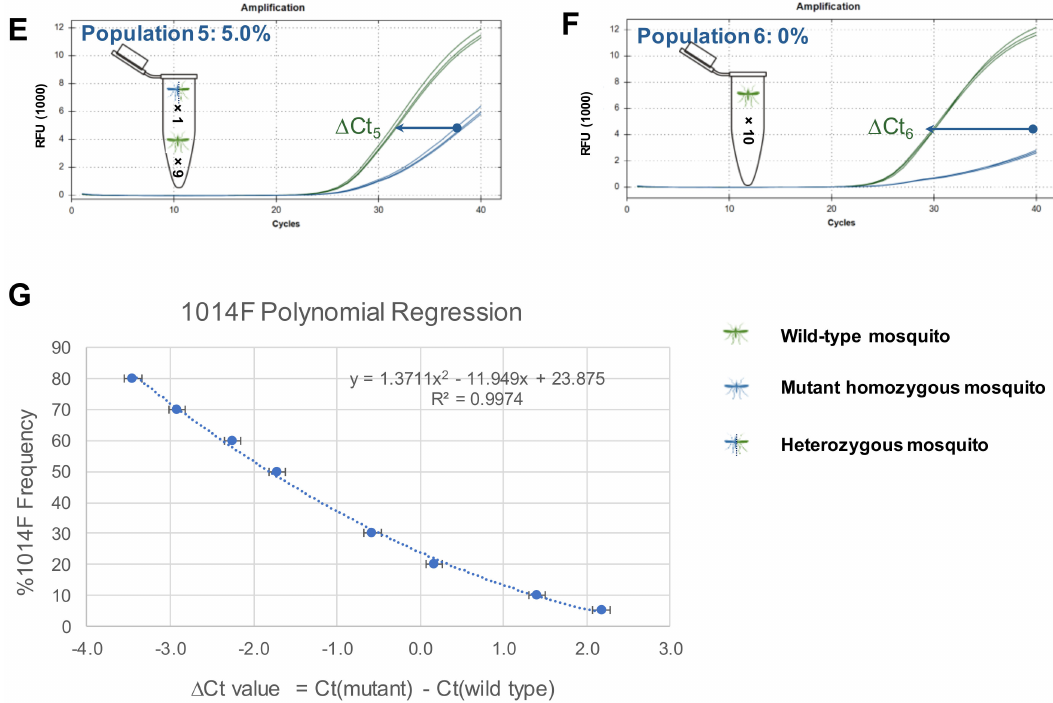
Figure 1. Development of regression models. A-F : Reaction curves for L1014F showing the increasing difference between cycling of mutant and wild type probes from higher to lower population frequencies of the mutant allele. G : Polynomial regression curve for 1014F.